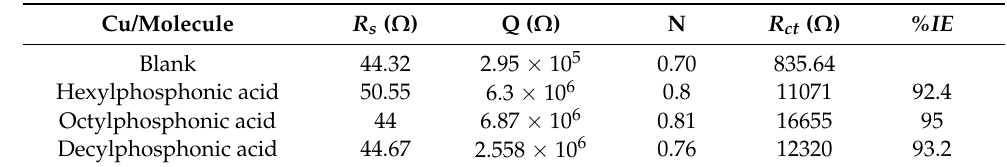
Table 1. The values of polarization resistance and inhibition efficiency of corrosion at Cu electrode modified with phosphonic acids.